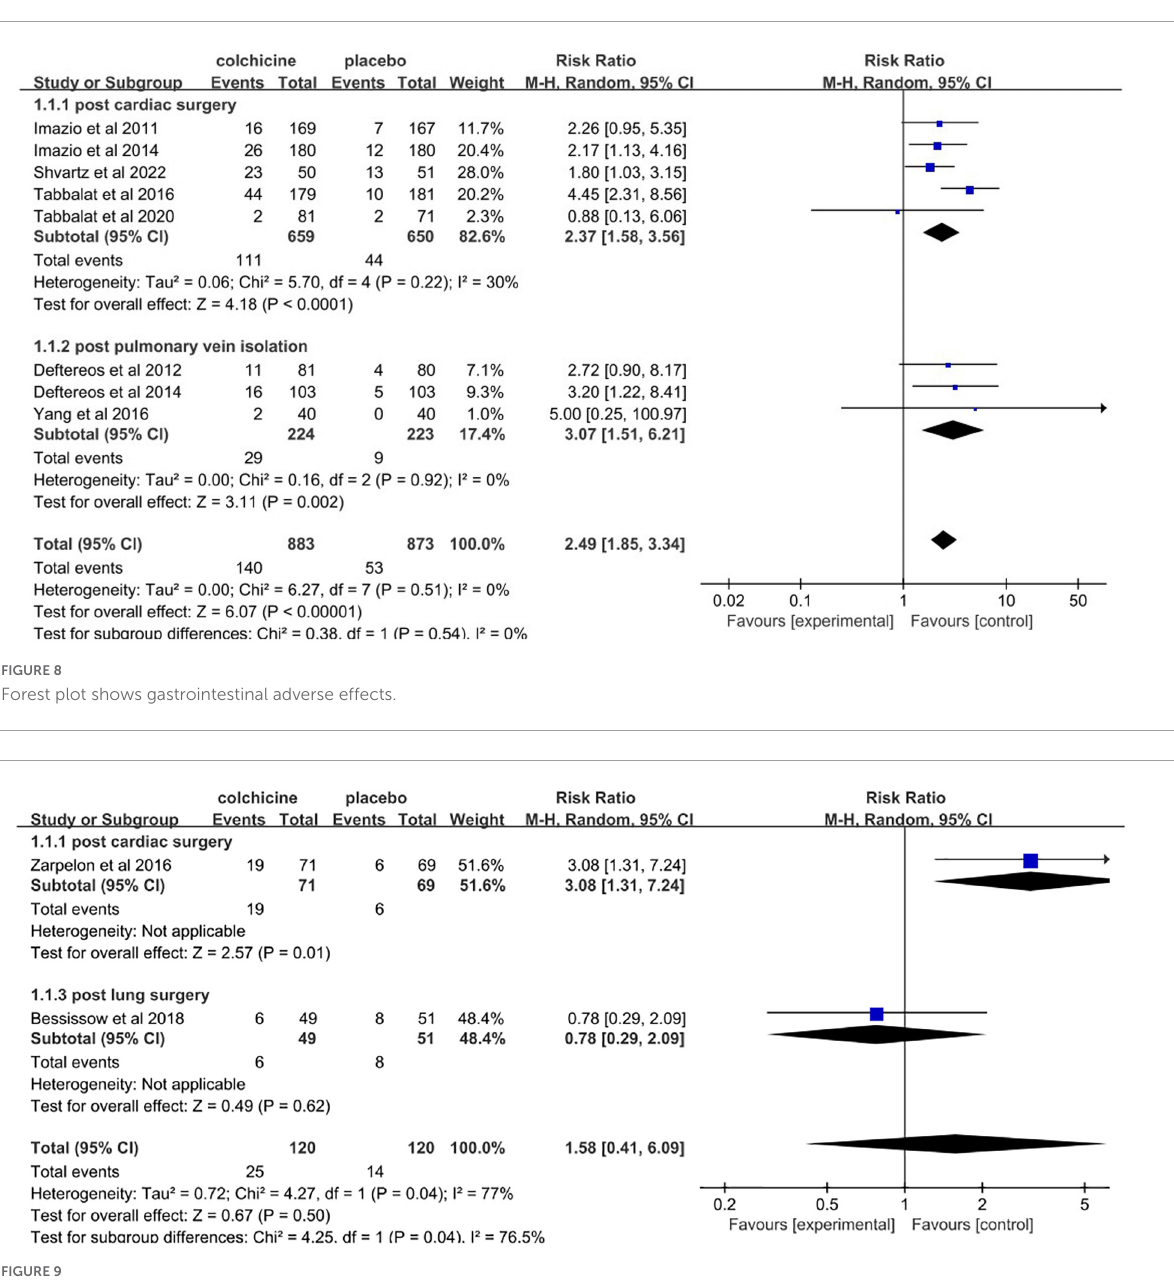
FIGURE9 Overall risk of